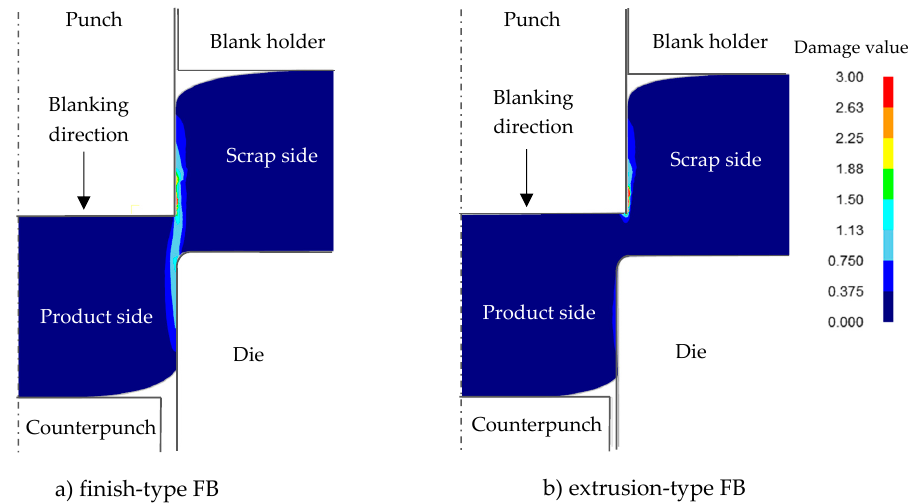
Figure 4. Comparison of damage value defined as the integration value corresponding to the evolution of the maximum principal stress σ max for 80% t punch penetration between finish-type fine blanking (FB) and extrusion-type FB: ( a ) finish-type FB; ( b ) extrusion-type